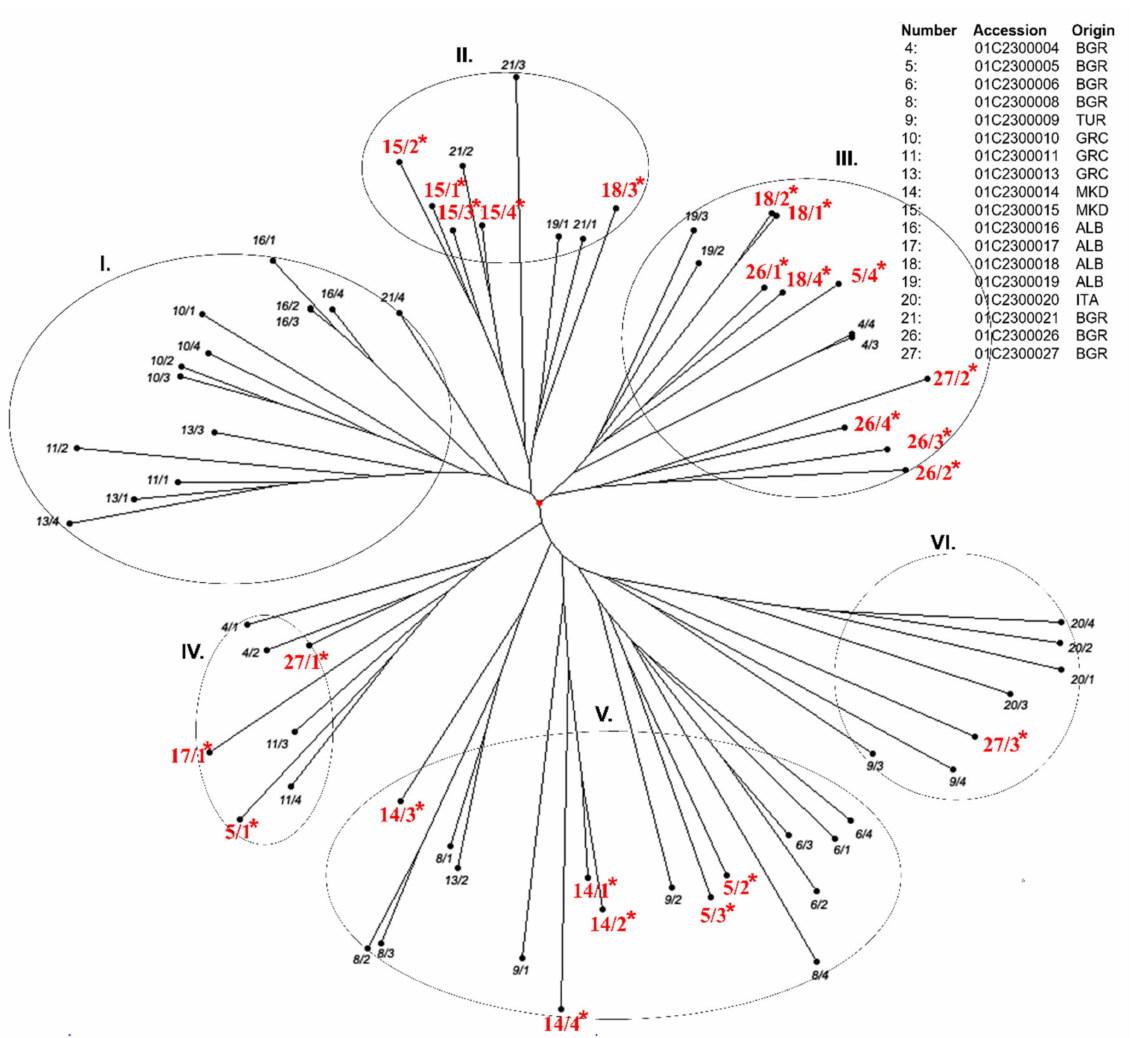
Figure 5. Cluster Analysis depicting genetic relationships among individual Dasypyrum accessions on basis of SDS-PAGE determining positions of seed HMW- and LMW glutelins. * Those in red were further used for evaluation of seed composition. Individual Roman numerals (I-VI) define more mutually similar groups of tested